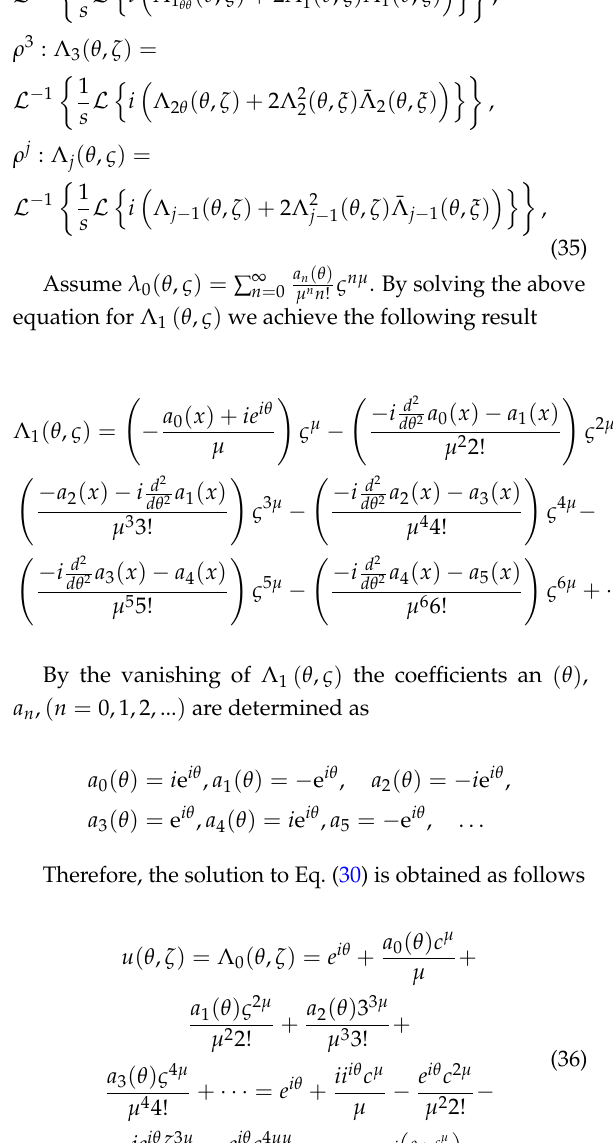
Fig. 2. 3D (left), 2D (middle) and contour (right) surfaces of real part Eq. (29) when µ =